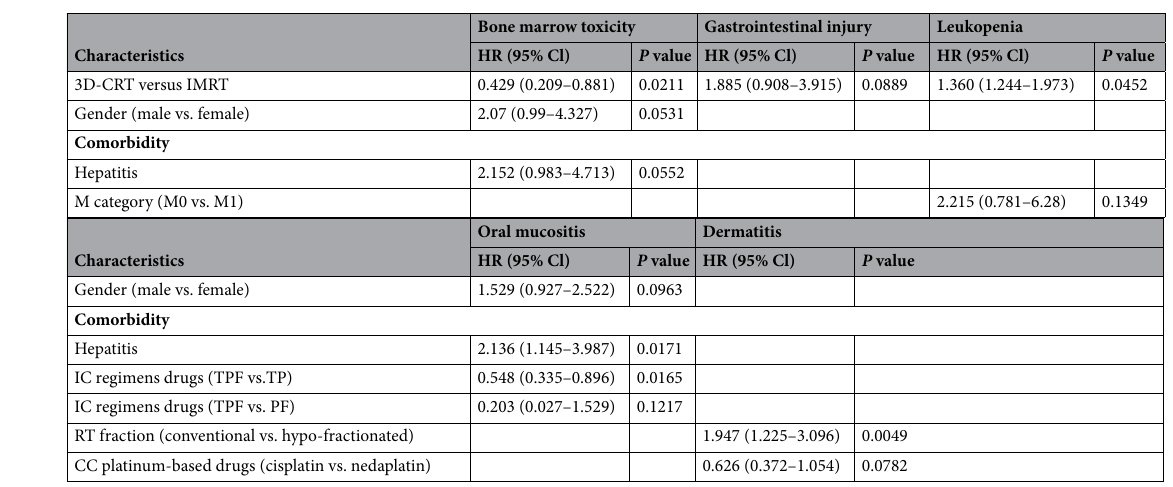
Table 4. Prediction of radiation-induced acute injuries in Cox proportional hazards analysis. IMRT intensity modulated radiation therapy, 3D-CRT three-dimensional conventional radiotherapy, IC induction chemotherapy, CC concurrent chemotherapy, RT radiotherapy. Hazard ratios (HR) were calculated with the Cox proportional hazards model, P values were calculated with the log-rank